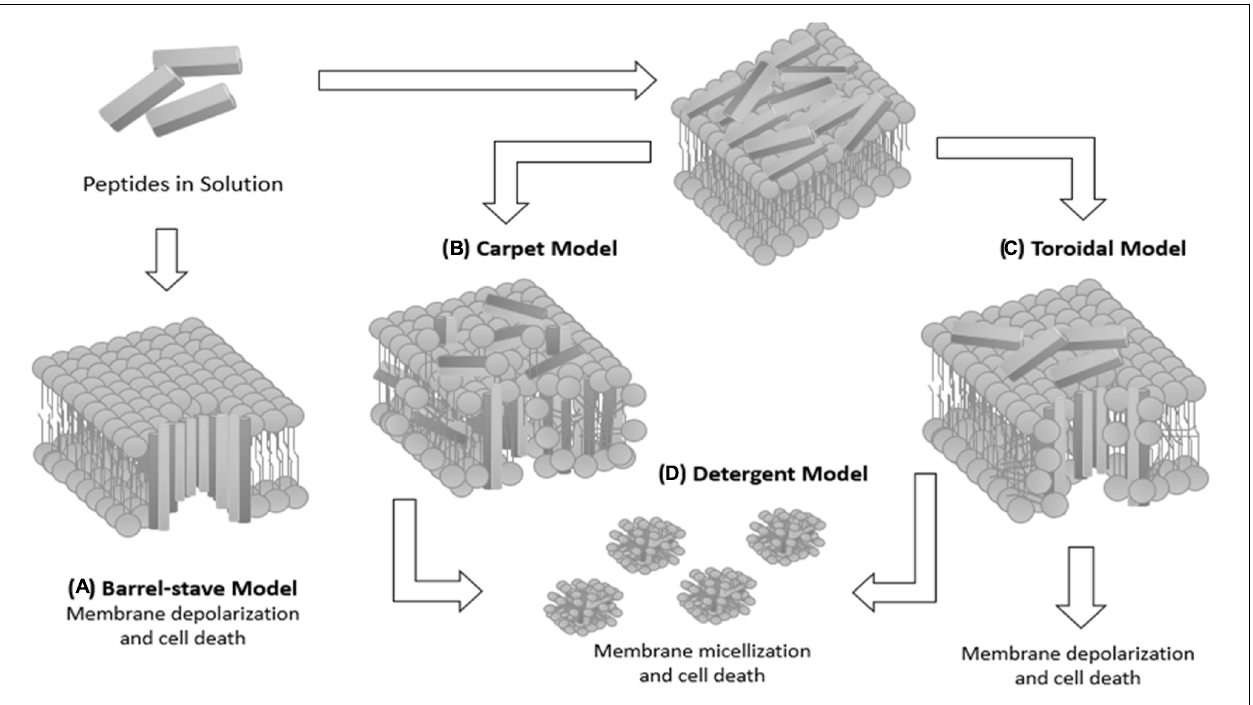
reaching a saturation point, resulting in solubilization of the bacterial membrane. (C) Toroidal model: the peptide helices are inserted parallel to the membrane and cause folding of the lipid monolayers in order to form a pore formed by peptides interspersed with phospholipids. In this model, an association between polar peptide groups with the lipid polar head groups is established. (D) Detergent model: membrane solubilization occurs, leading to formation of micellar structures, resulting in the destabilization of the lipid membrane and cell